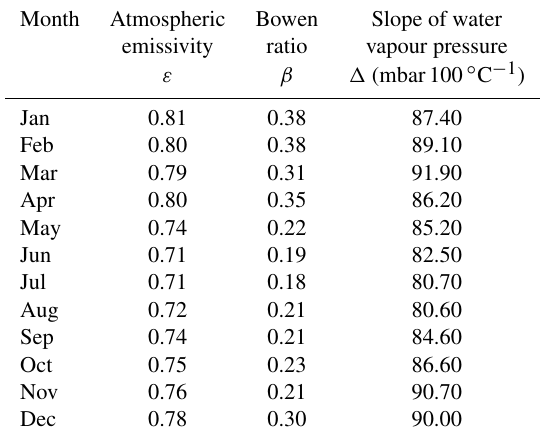
Table 4. Monthly average parameters for evaporation calculations for the 2015–2016 period.